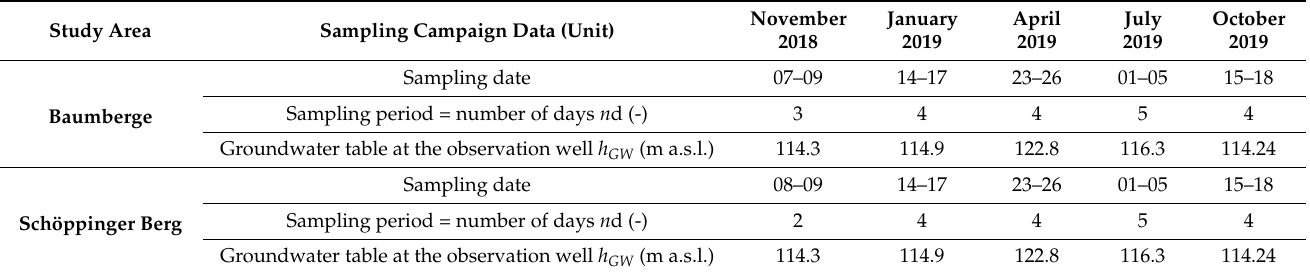
Table 1. Precondition of field work for sampling eight springs in Baumberge and Schöppinger Berg between